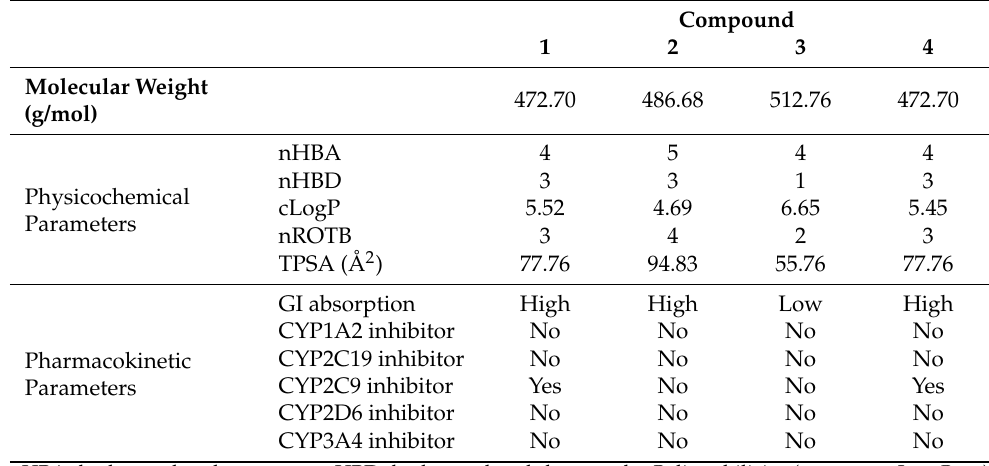
Table 2. In silico predicted physicochemical and pharmacokinetic parameters of compounds 1 – 4